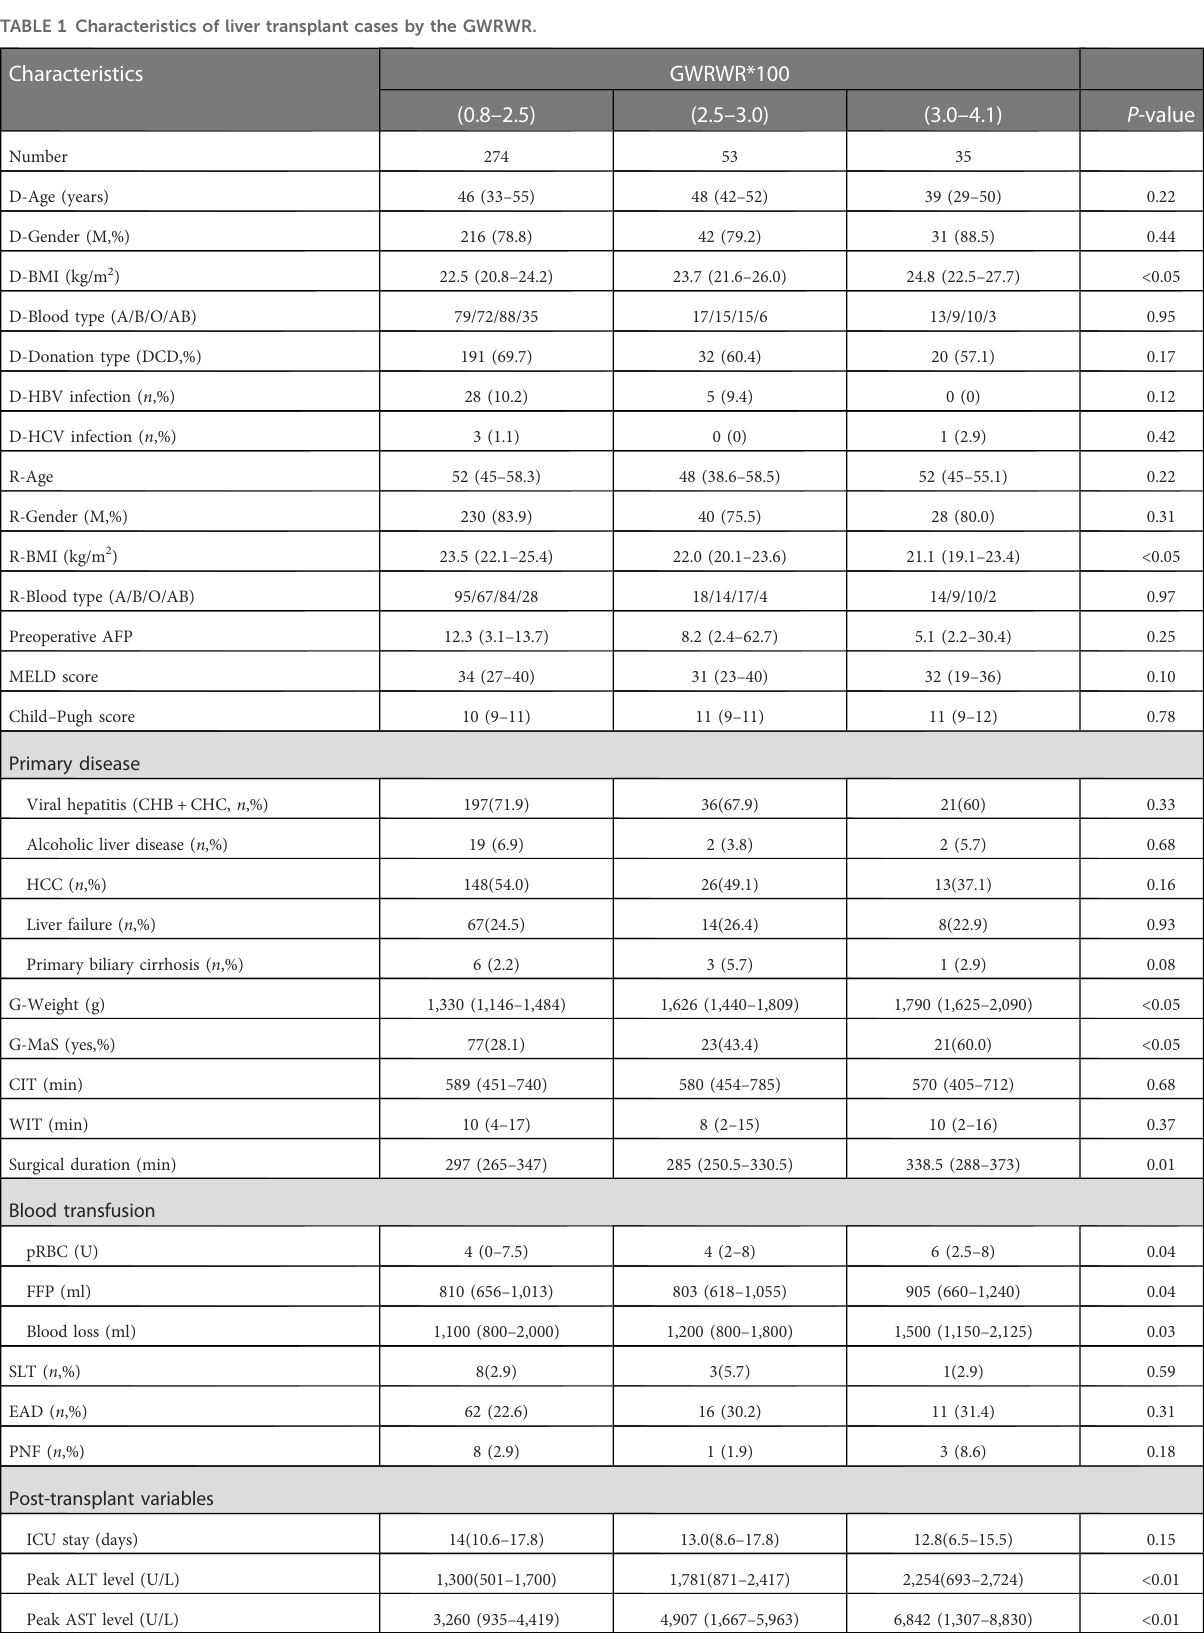
TABLE 1 Characteristics of liver transplant cases by the GWRWR.